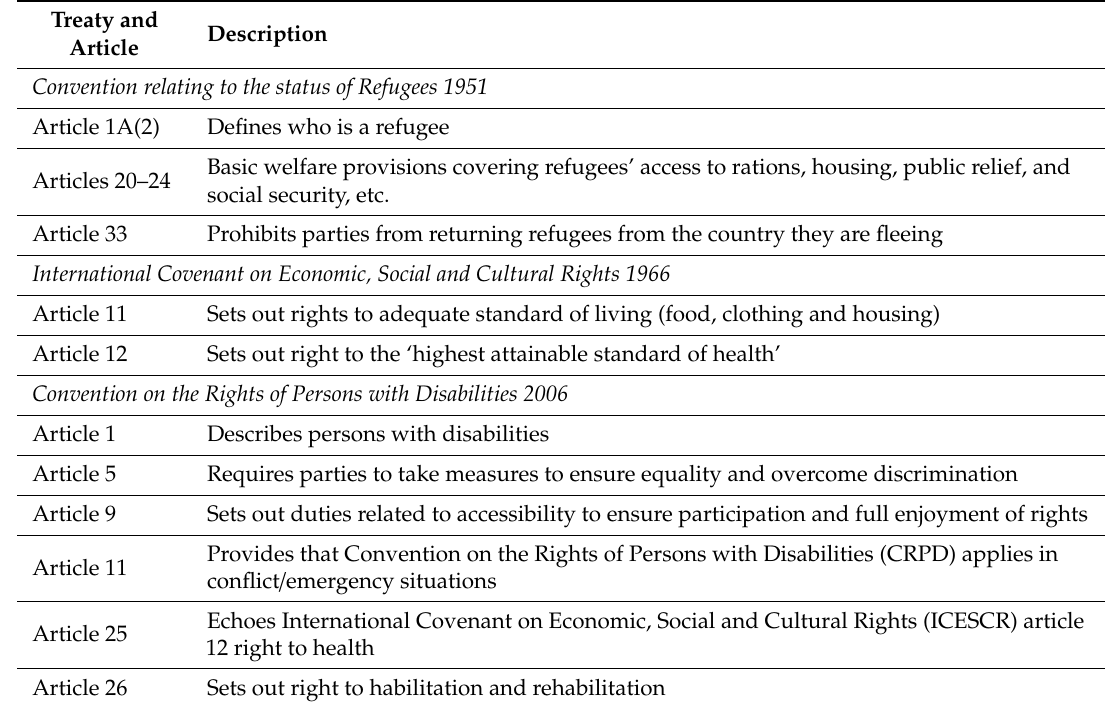
Table 1. Human rights treaties—Relevant articles and their e ff ects.